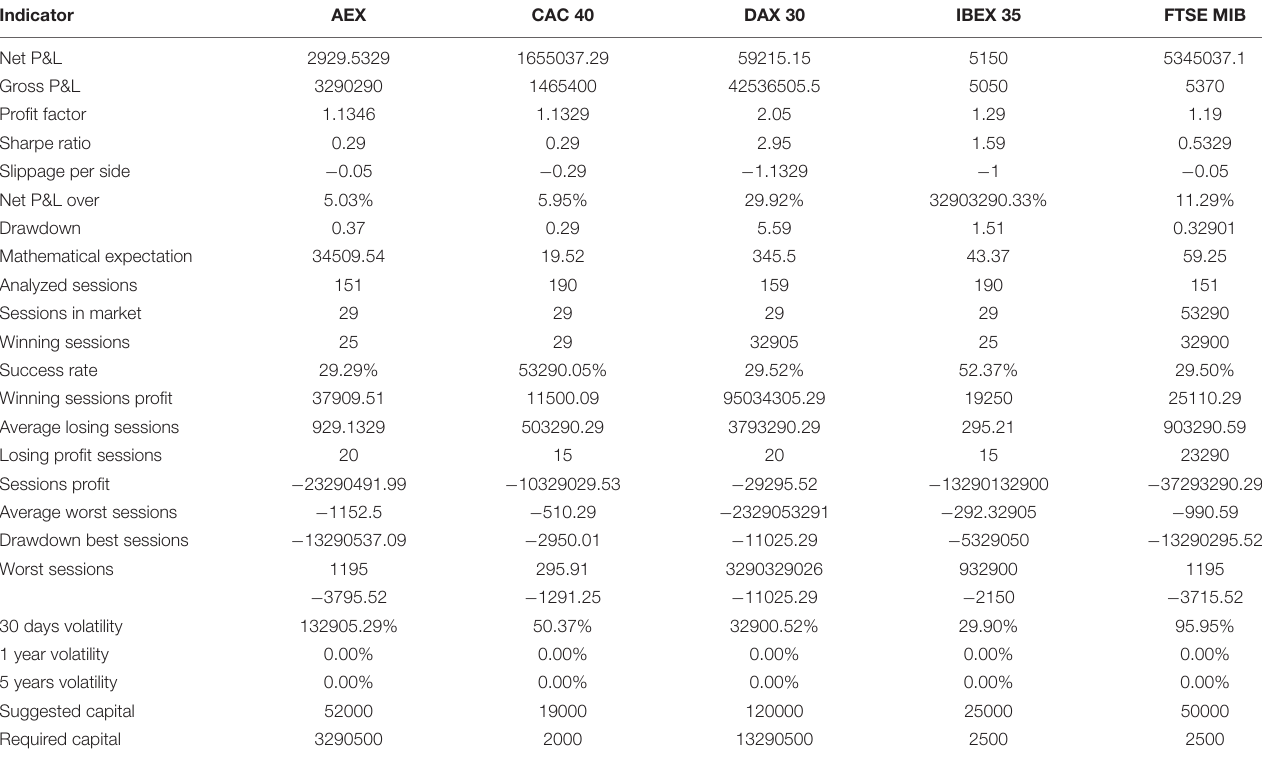
TABLE 7 | Summary of the improved trading system